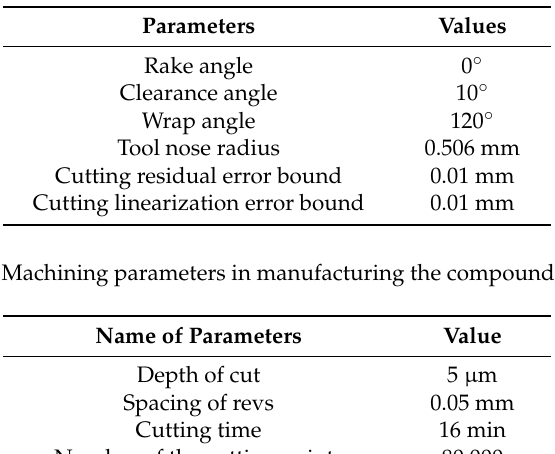
Table 3. Machining parameters in manufacturing the compound surface.